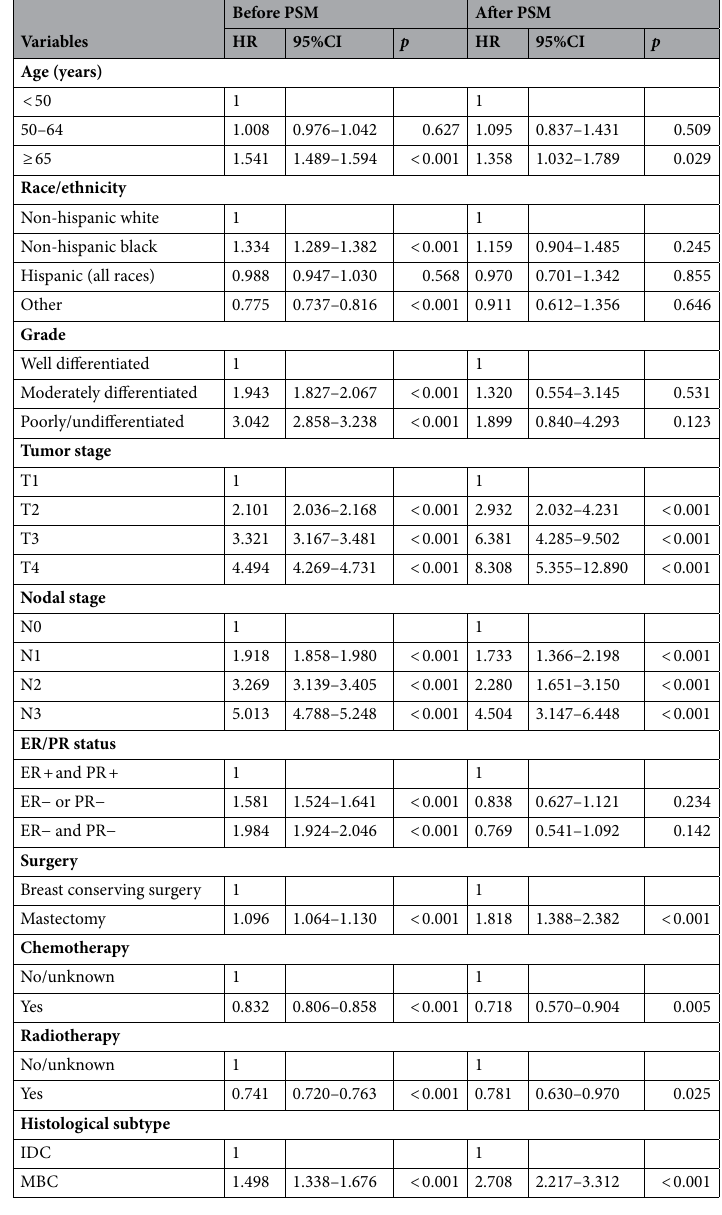
Table 2. Multivariate analysis on prognostic factors for breast cancer specific